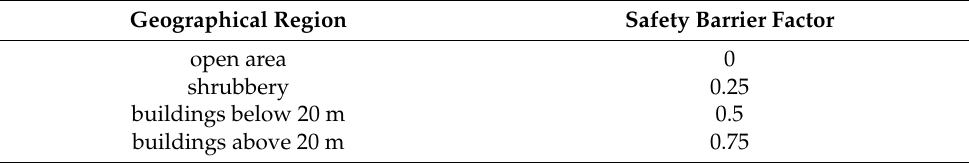
Table 2. Surface safety barrier